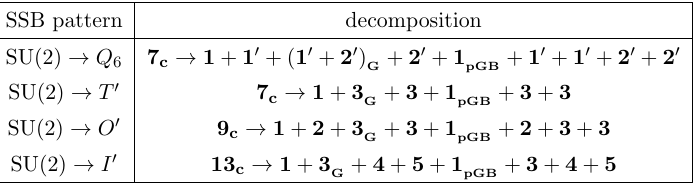
Table 15 . Scalar mass eigenstates for the SSB patterns SU(2) ! Q 6 ; T 0 , O 0 and I 0 using